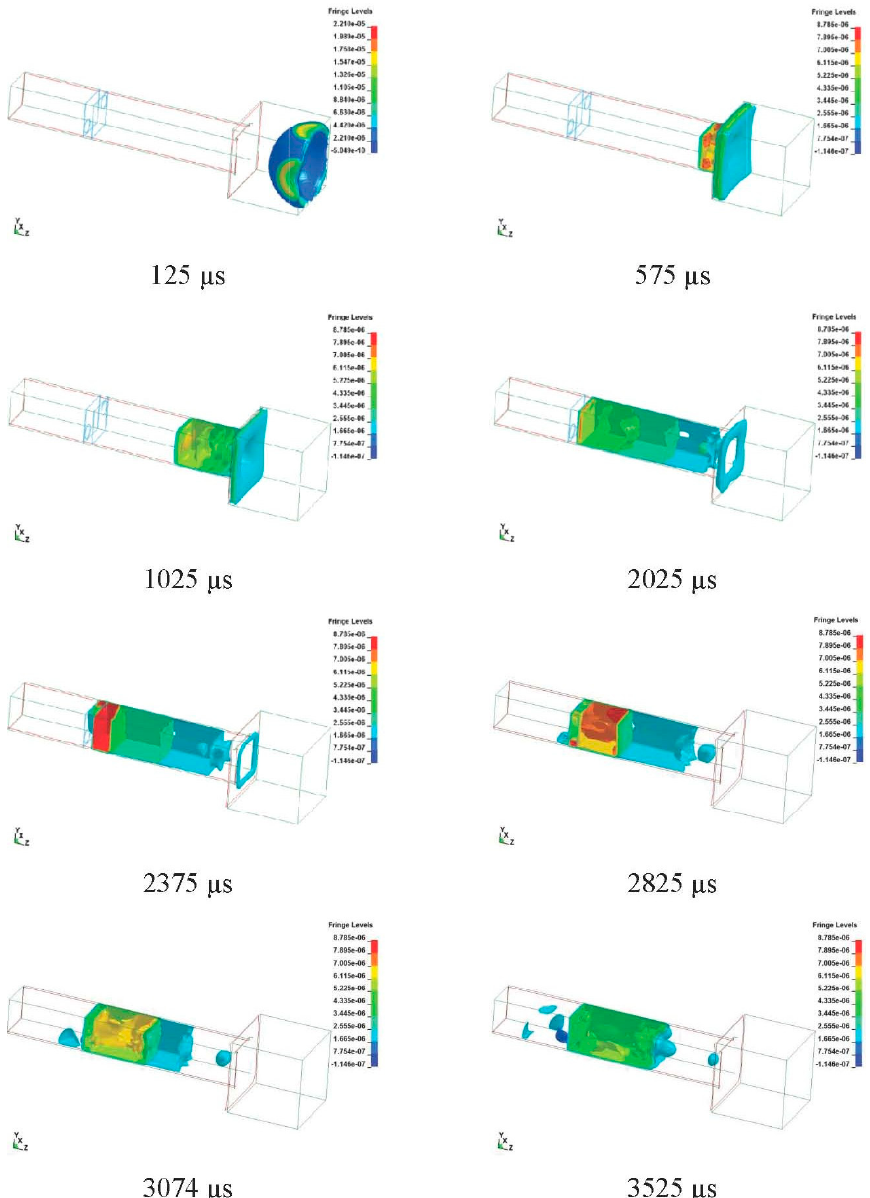
Figure 10. Blast transfer in numerical simulation of linear tunnel with double-pressure relief orifice plate explosion (100 g C-4). Table 4 shows the percentage error between the experimental and numerical results of the three models. Although significant difference was observed in some cases, espe- cially the double-orifice plate at P3, most cases agreed with the test results. It is worth noting that it is challenging to simulate a perfect match with the field test, especially in an explosion test, where highly nonlinear dynamic loading exists. The quality and density